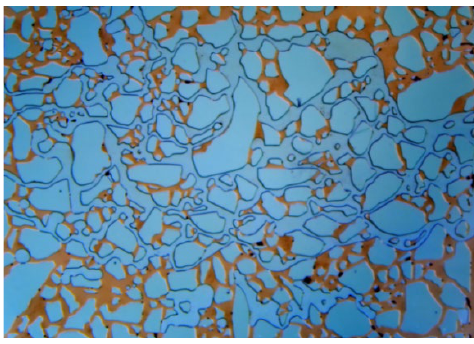
Figure 16. Remaining oil occurrence at 20 MPa and 45 min.